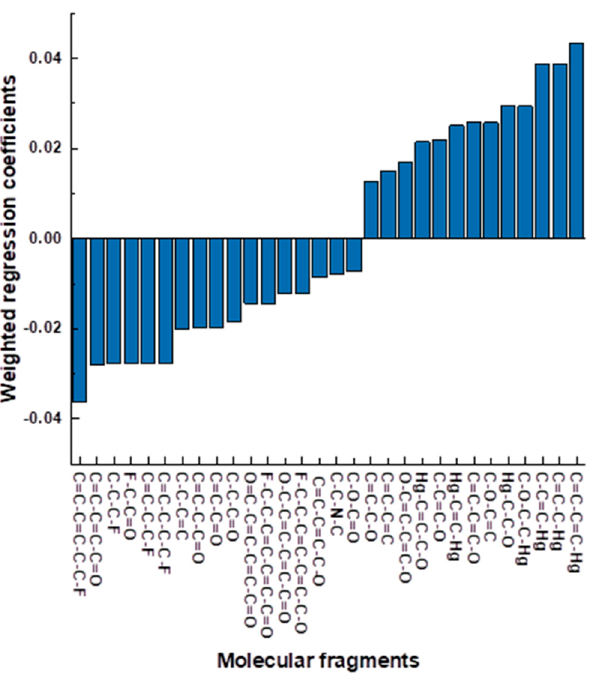
Figure 4. Fragments with the largest contribution in logK sel (HCO 3 − /Cl − ) values, where ‘-’ is a single bond and ‘=’ is a double bond.